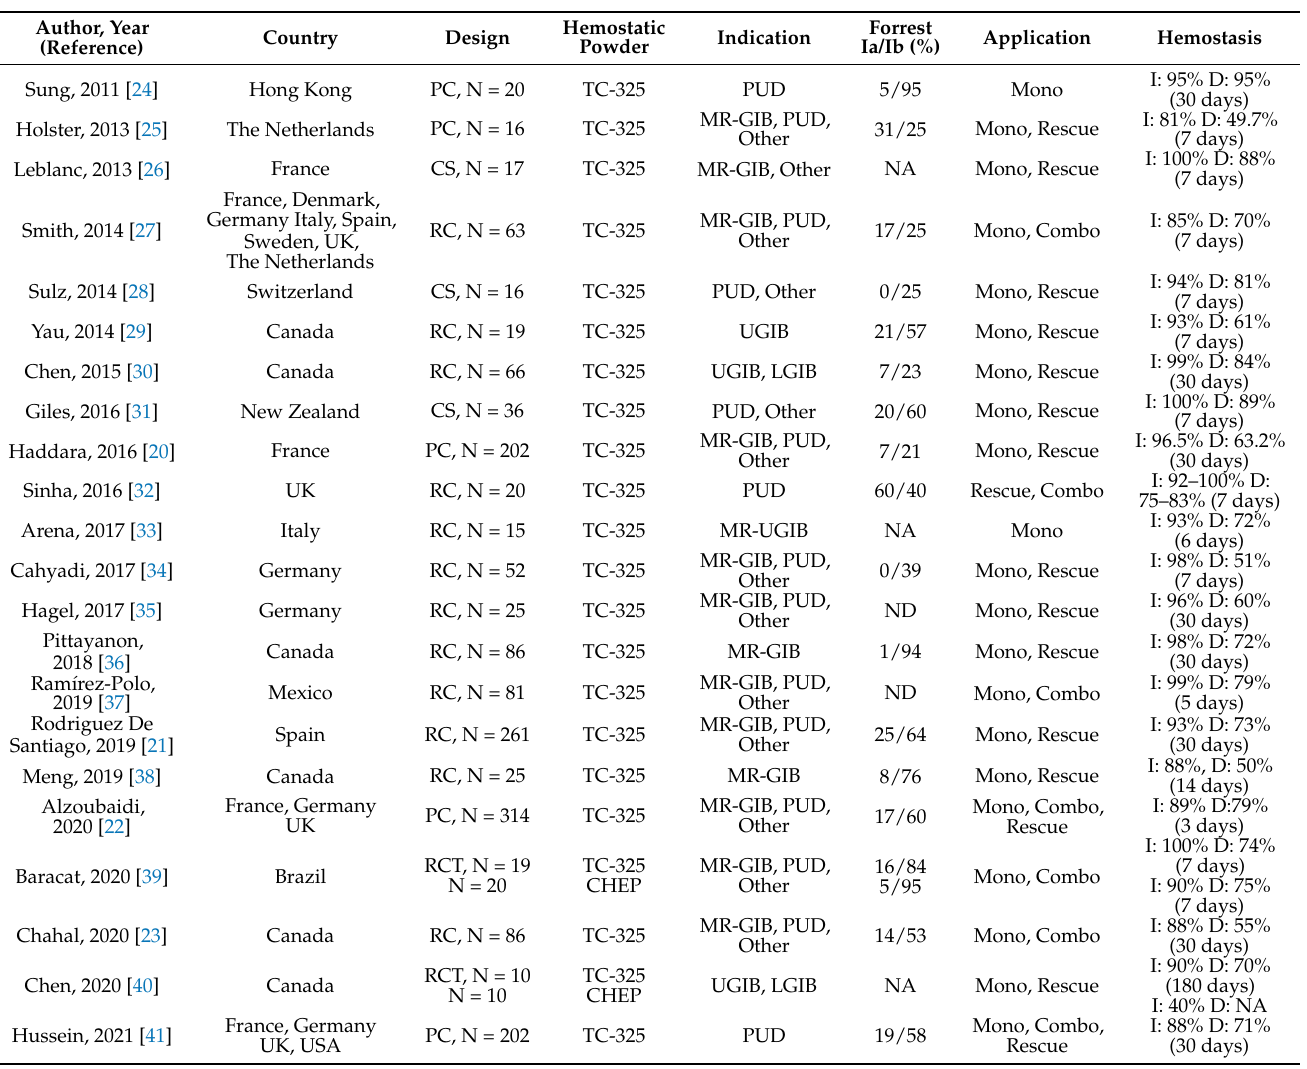
Table 2. Studies on hemostatic powders and outcomes in patients with upper gastrointestinal